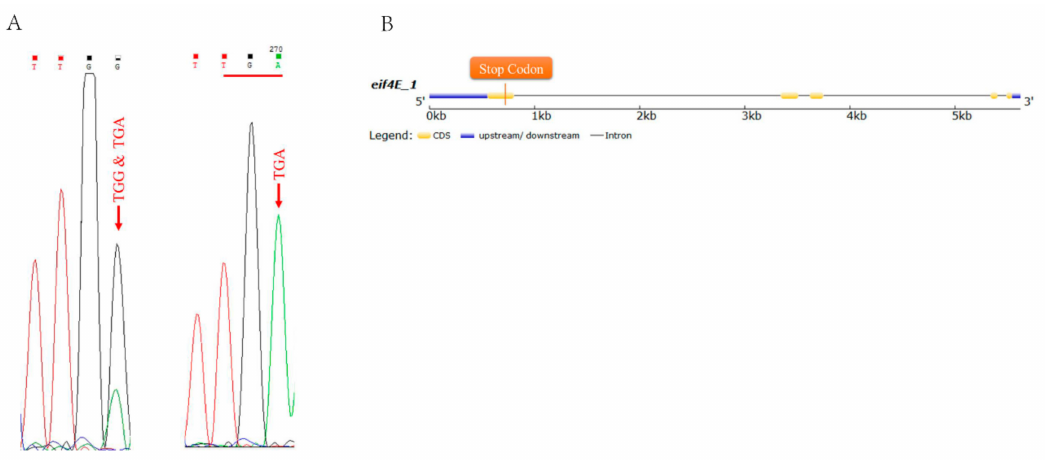
Figure 1. Genotyping of M3 generation progeny of line 918P: ( A ) Sequencing trace results showed mutant alleles with heterozygous genotypes (left) and mutant allele with homozygous genotype (right); ( B ) Schematic diagram of eIF4E1-S gene. Stop codon introduced by EMS (ethyl methanesulfonate) mutagenesis was found in exon 1 of the eIF4E1-S